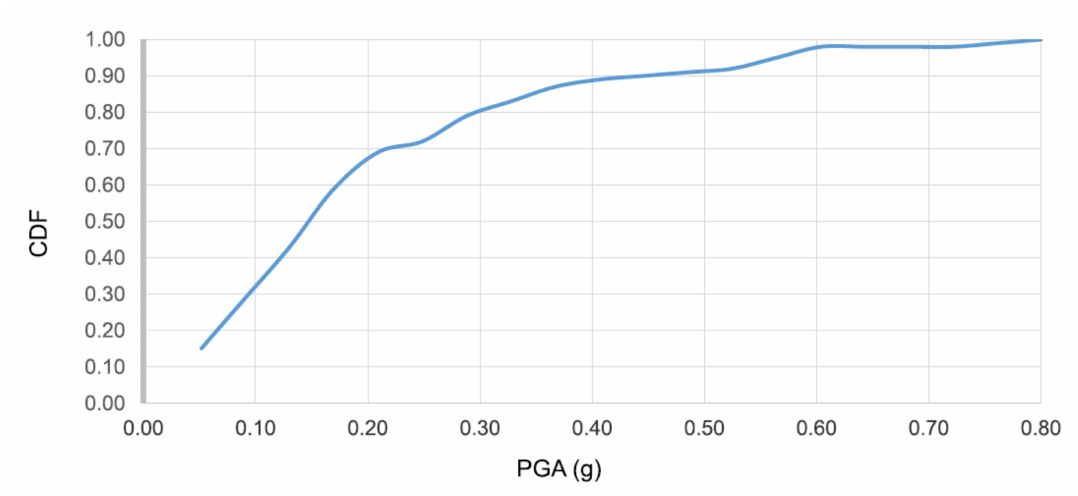
Figure 7. Benchmark